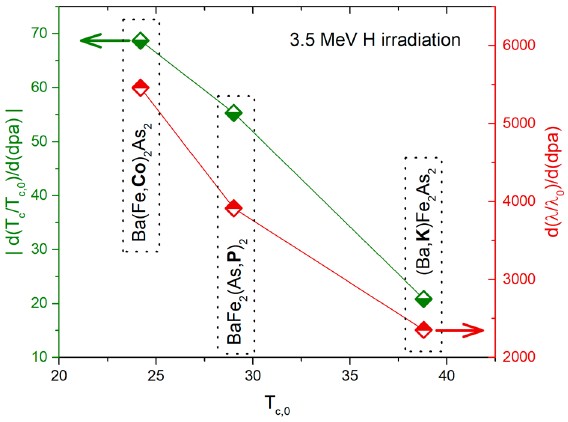
Figure 7. Scaling relations of the absolute value of the critical temperature degradation rate, | d ( T c / T c ,0 )/ d ( dpa ) | , and London penetration depth increase rate, d ( (cid:31) (5K)/ (cid:31) (5K) 0 )/ d ( dpa ) , with the critical temperature of the pristine sample, representative of the strength of the superconducting